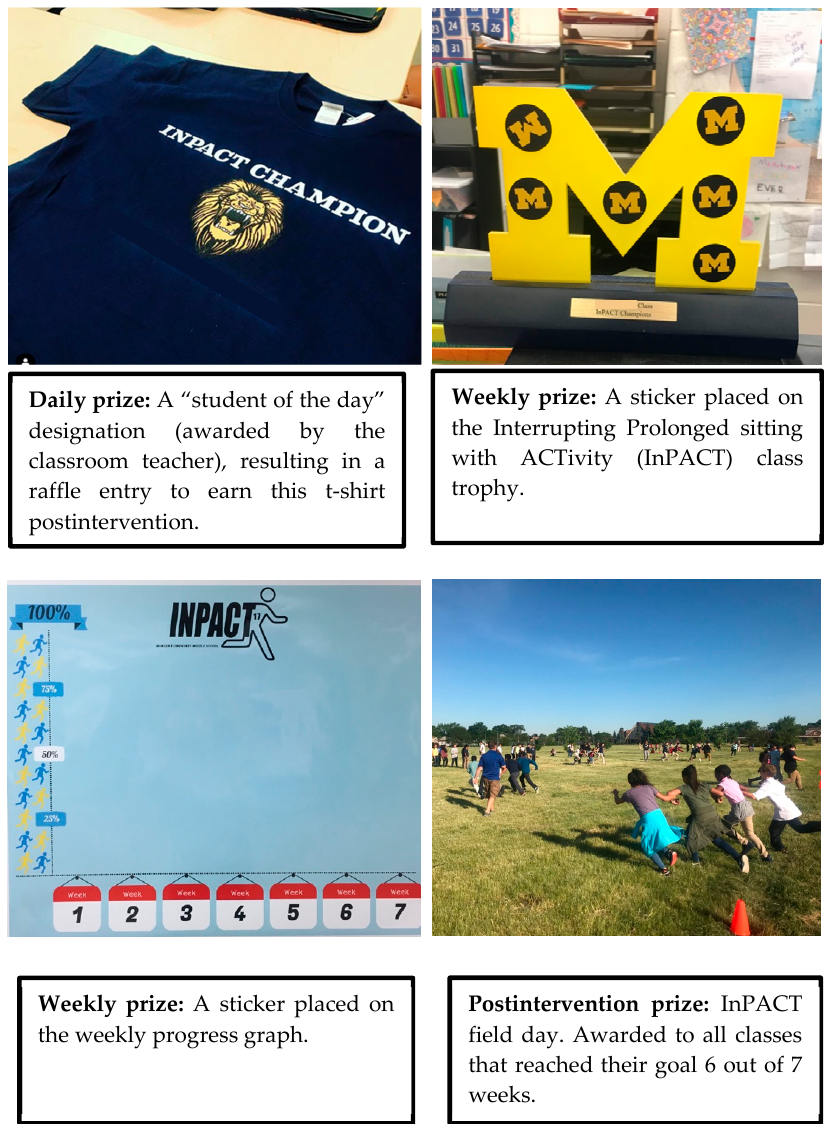
Figure 1. The gamified intervention daily, weekly, and postintervention prizes.